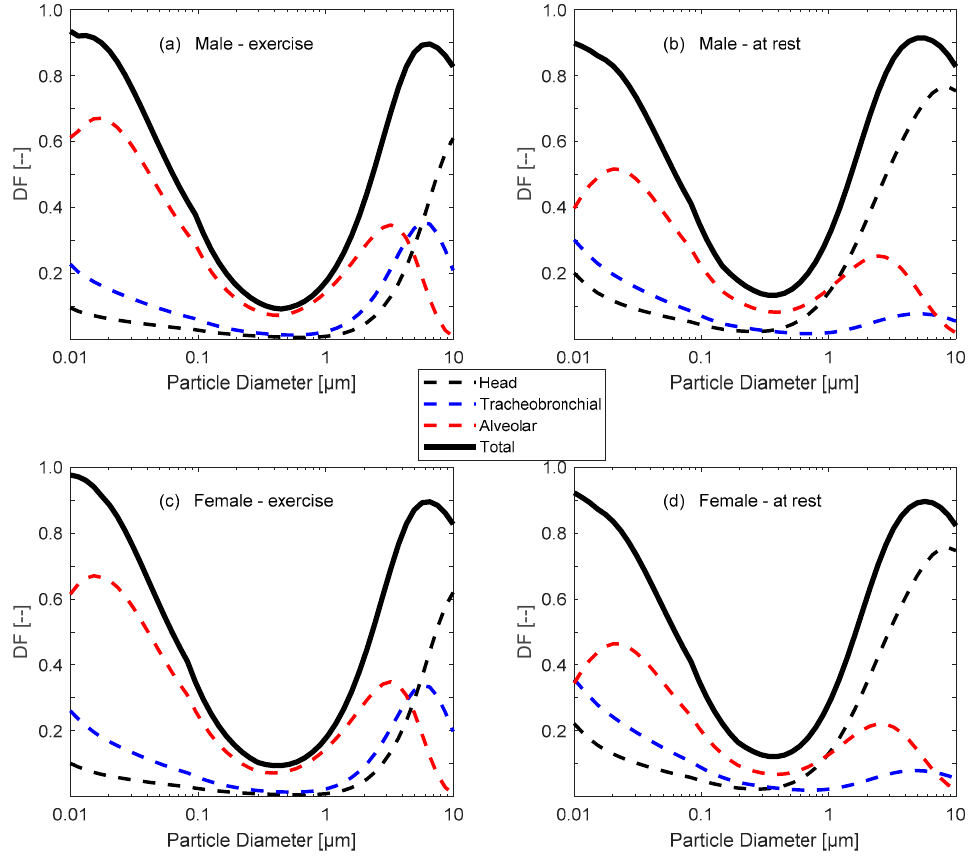
Figure 1. Deposition fraction ( DF ) curves in an adult: ( a ) male exercising, ( b ) male at rest, ( c ) female exercising, and ( d ) female at rest.